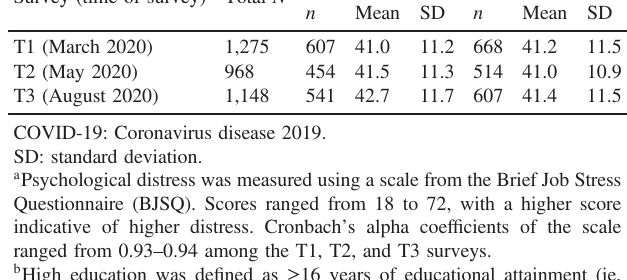
Table 4. Excess e ff ects of low educational attainment on psychological distress a across three consecutive sur- veys (T1-T3) of full-time employees in Japan during the COVID-19 pandemic: mixed model with repeated measures ( N = 1,275) Estimates of fi xed Comparison between surveys Table 2. Crude means of psychological distress a at baseline (T1), T2 and T3 under the COVID-19 pandemic among a cohort of Japanese full-time employees ( N = 1,275) Low Education b Survey (time of survey) Total N